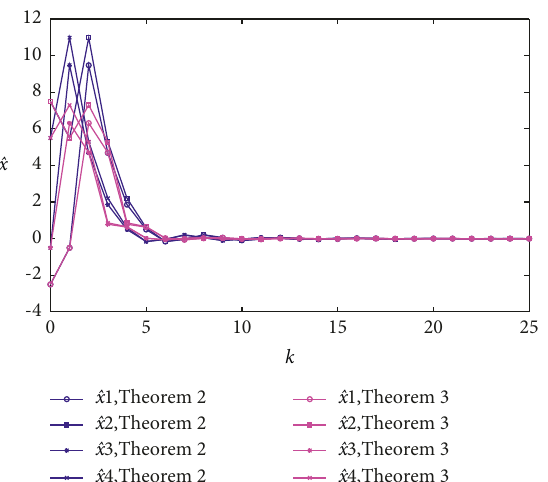
Figure 18: State trajectory with δ � 0 . 6756.